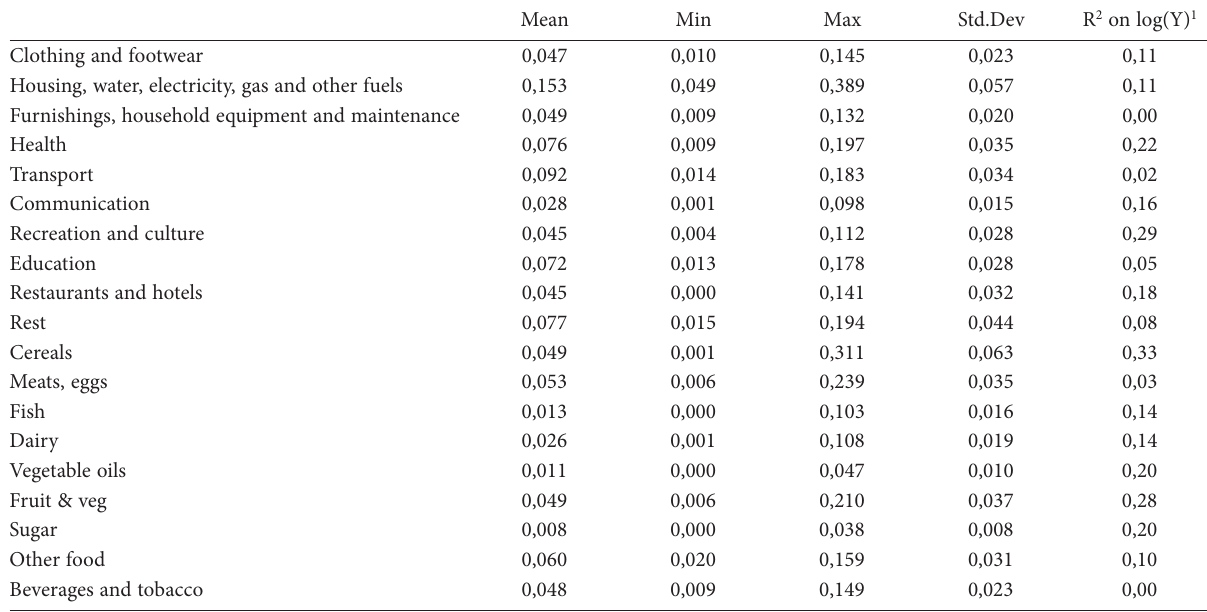
Table 2. Statistics on budget shares derived from ICP data.